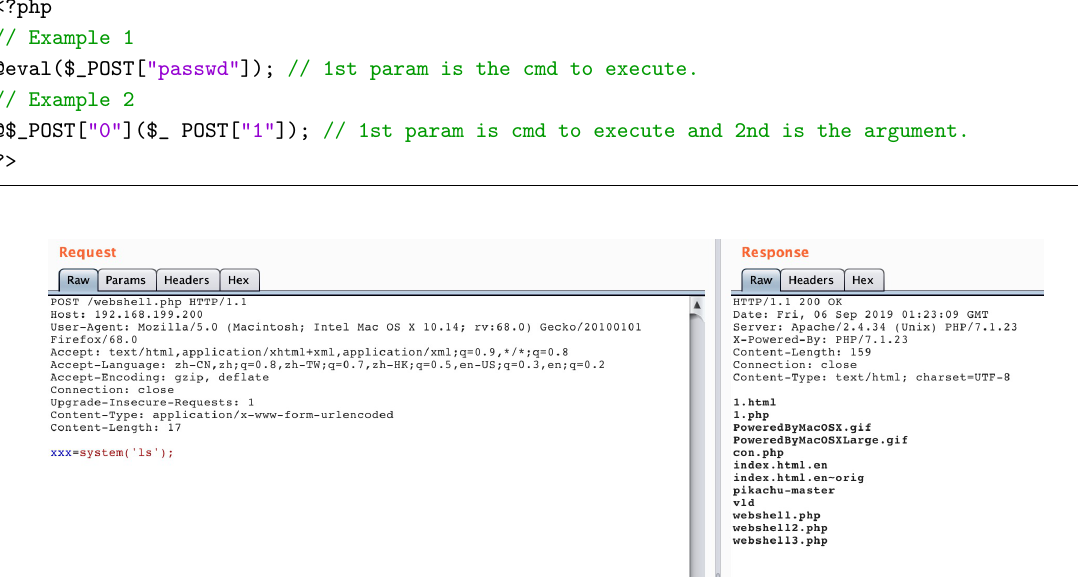
Figure 2. Attack example remotely executing the ls